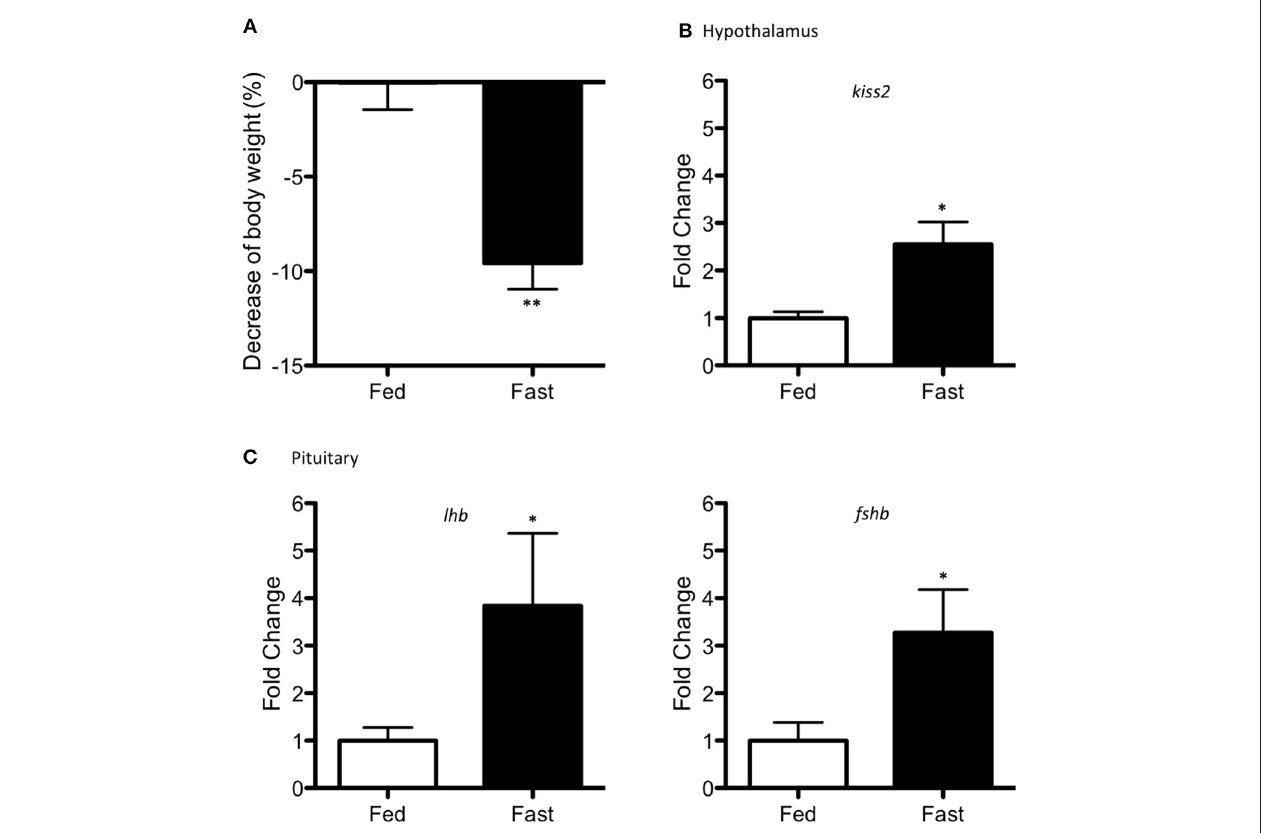
FIGURE 5 | Effects of fasting (15 days period) in adult pejerrey. (A) Decrease of percentage in body weight during feeding and fasting conditions. (B) Expression levels of kiss2 in the hypothalamus. (C) Expression levels of lhb and fshb in the pituitary. Results are represented as fold change after data normalization against β -actin levels Asterisks indicate statistically significant differences after the Student’s t -test. ** p < 0.01; * p < 0.05. Data shown are expressed as mean ± S.E.M. ( n =